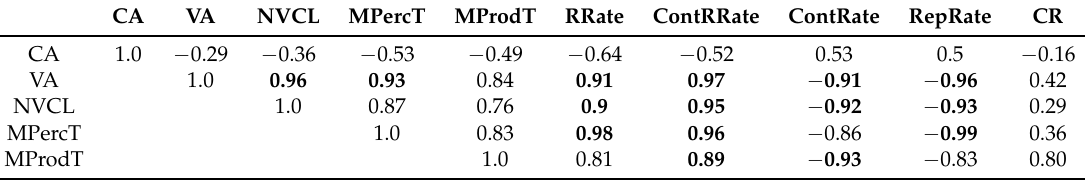
Table 6. Correlation values (Pearson correlation coefficient) between C1 speakers’ profile variables (Table 2) and evaluators’ assessment (Table 5). RRate means the percentage of Right judgments of the prosody expert. ContRRate, ContRate and RepRate mean the percentage of Cont.R, Cont. and Rep. evaluated by the therapist, respectively. CR means the classification rate of the SVM classifier. Values in bold represent statistically significant correlations with p -value <